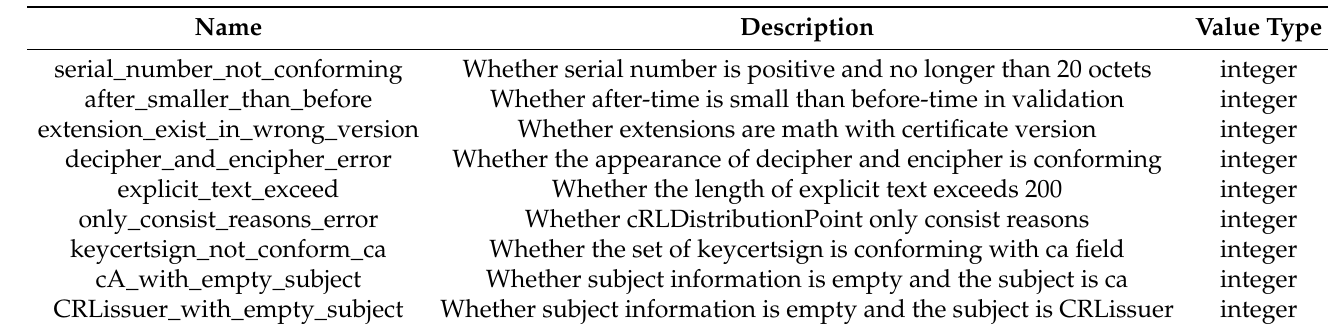
Table 2. Details of checking